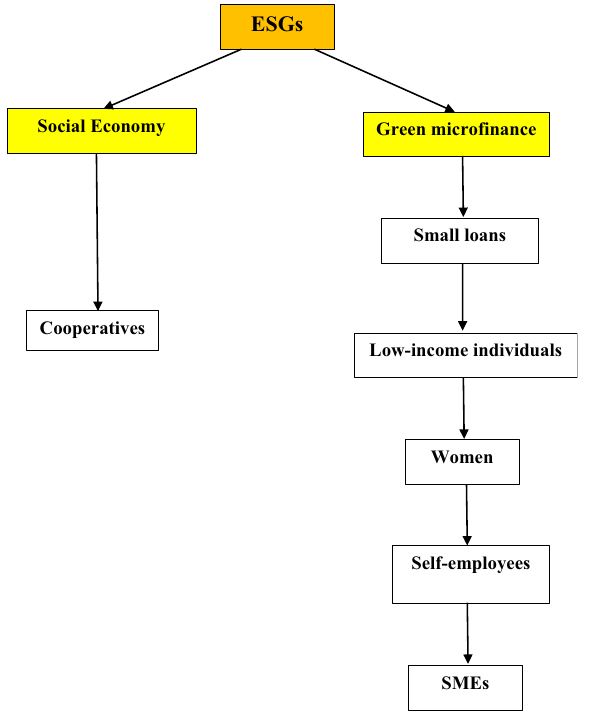
Fig. 1 Schedule of section1. It exhibits two paths where the environmental, social and governance (ESG) criteria can be developed: social economy and green micro fi nance. The framework of this paper is green micro fi nance. Source: Own